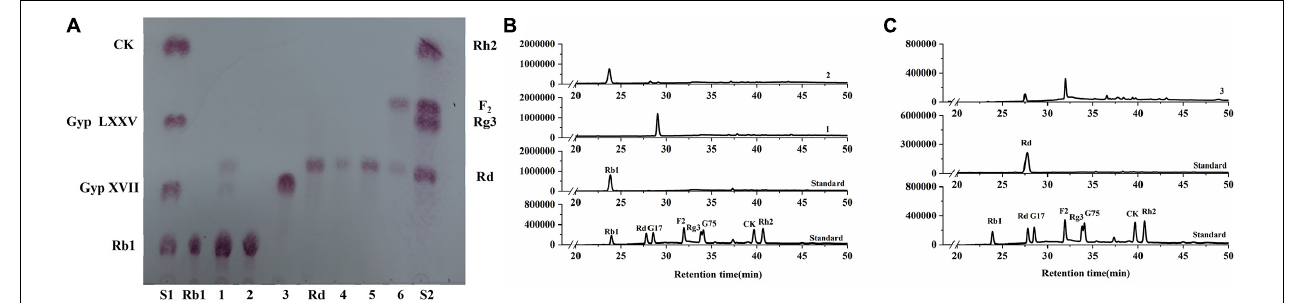
FIGURE 6 | Thin-layer chromatography (A) and high-performance liquid chromatography (B,C) analyses of the degradation products of Rb1 (B) and Rd (C) by BaBgl1A, BaBgl3A, and BaBgl3B. The degradation of Rb1 by BaBgl1A is shown in (A3 B1). The degradation of Rb1 by BaBgl3A is shown in (A1 B2). The degradation of Rb1 by BaBgl3B is shown in (A2). The degradation of Rd by BaBgl1A is shown in (A6 C3). The degradation of Rd by BaBgl3A is shown in (A4). The degradation of Rd by BaBgl3B is shown in (A5). The reaction was incubated with recombinant enzymes at 37 ◦ C for 2 h.